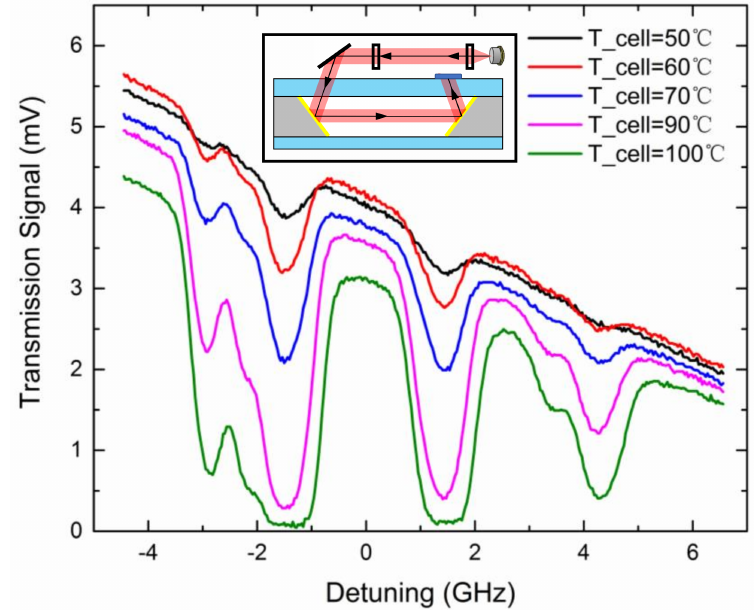
Figure 9. Rubidium D1 line absorption spectroscopy with 5 mm long return reflection at different temperatures and the return reflection optical configuration